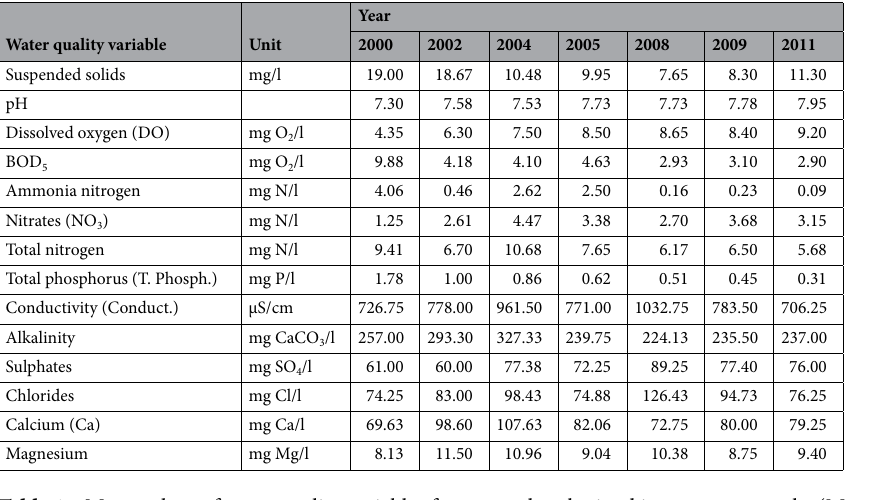
Table 1. Mean values of water quality variables from samples obtained in summer months (May–August) in the recovered course of the Ner River, Poland. Abbreviations of variable names that are used in the RDA figure are given (if different from those used here) in